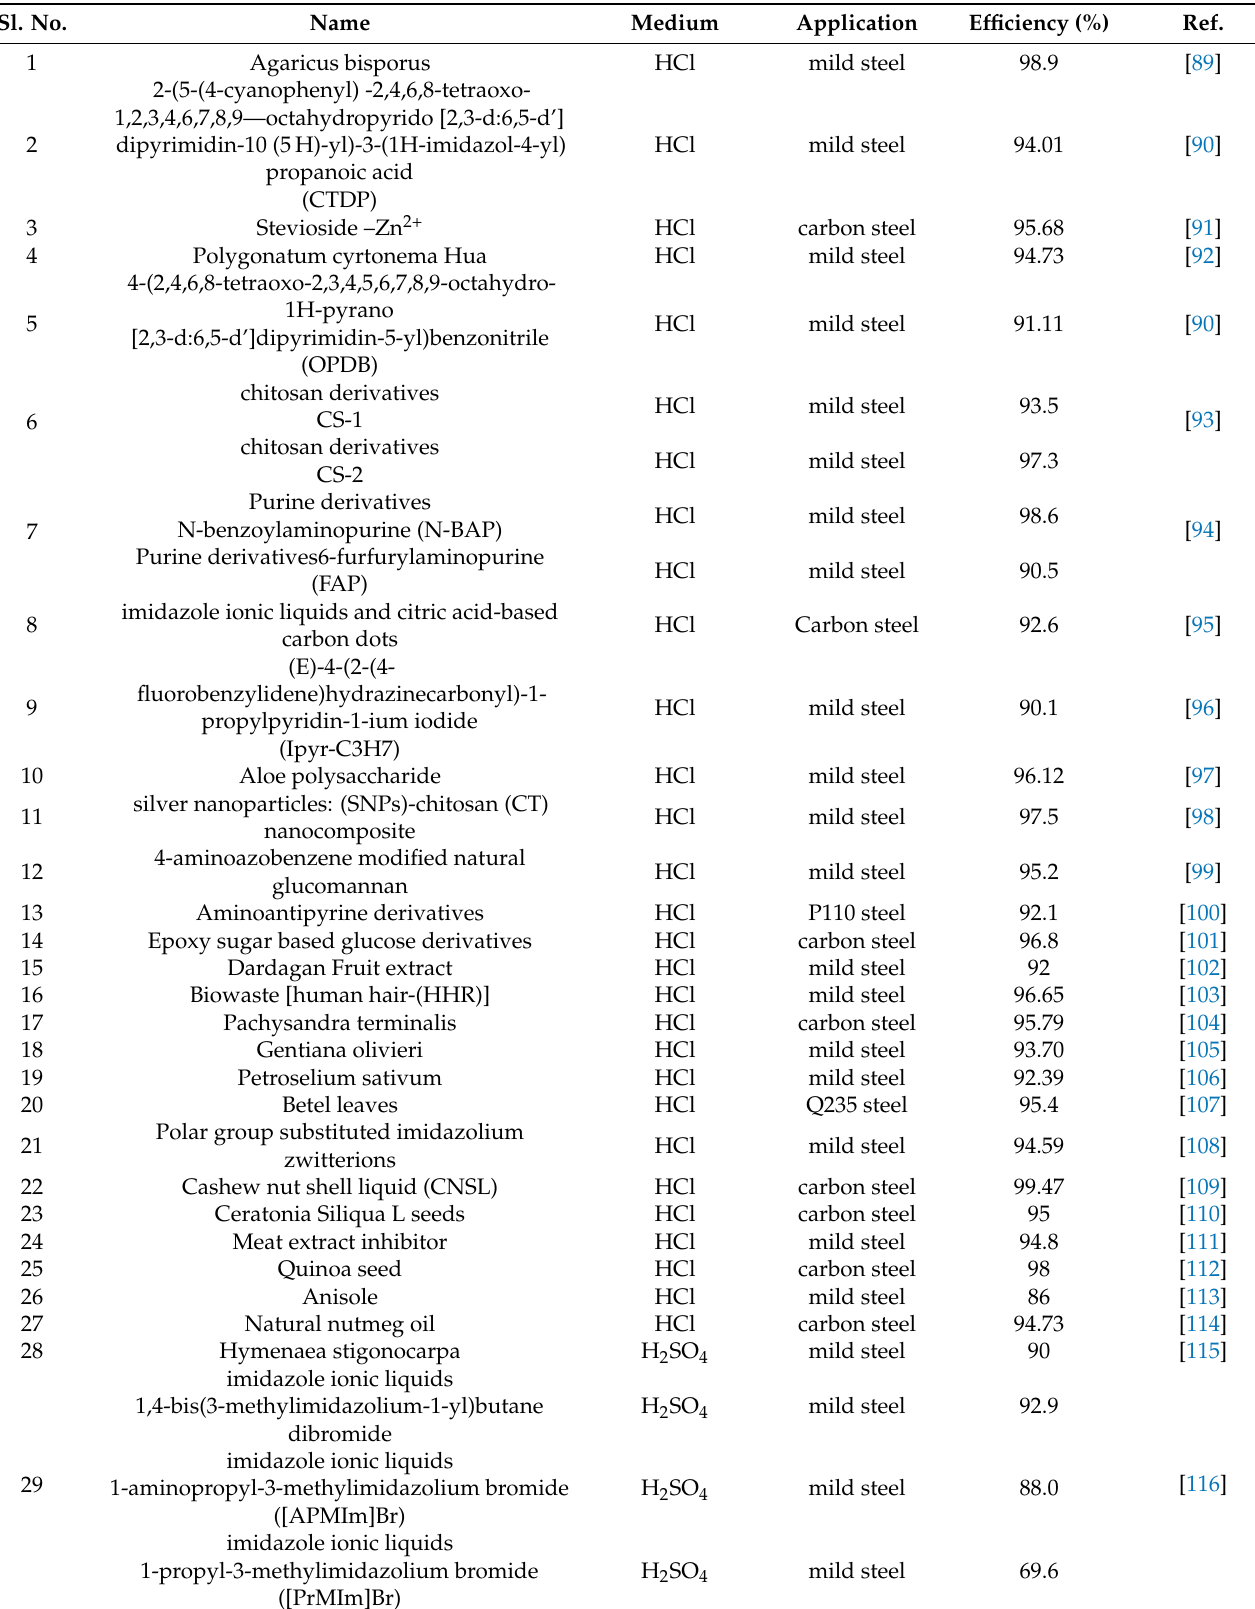
Table 1. Latest updates from 2019 to till date on eco-friendly inhibitor to mitigate the corrosion of steel in acidic environment. Sl.